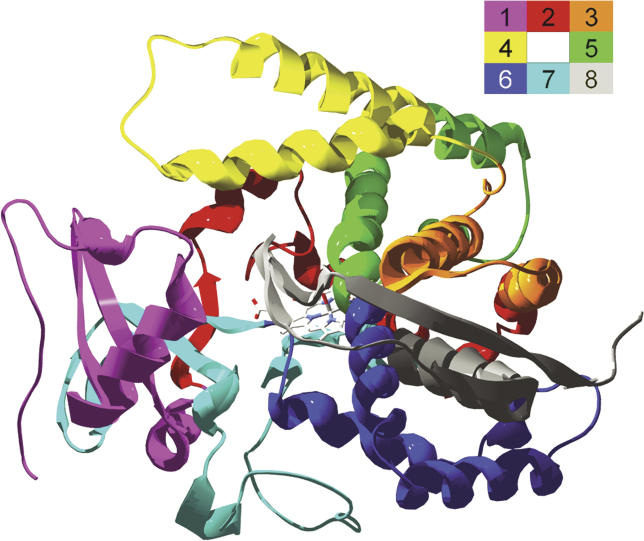
Structural Model of Heme-Domain Backbone Structure Showing Positions of Each BlockModel is based on the crystal structure of CYP102A1 (2HPD) [
26]. Blocks are color-coded as shown and heme is shown in CPK coloring.